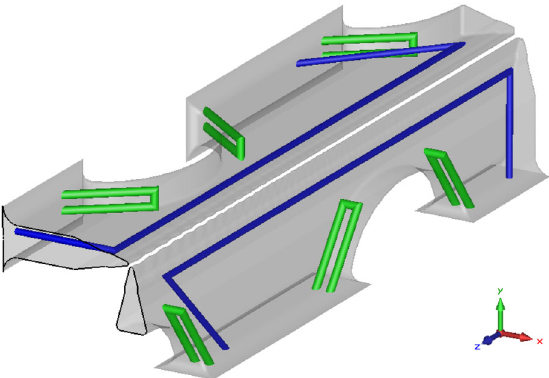
FIG. 24. Multiphysics scheme based on CST and ANSYS .